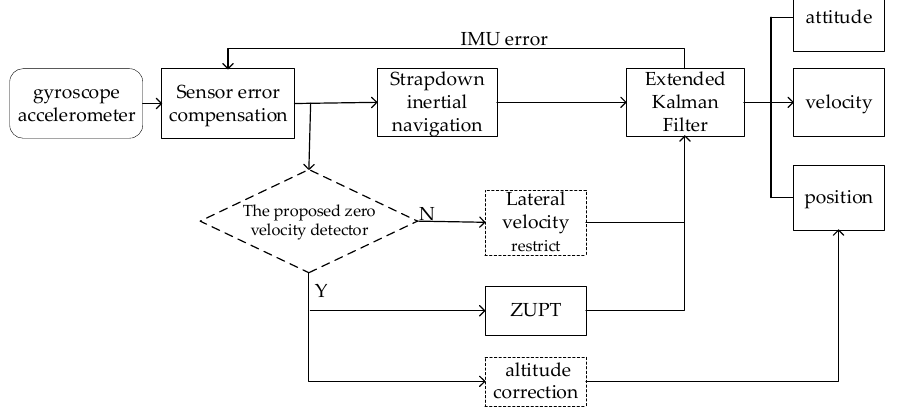
Figure 4. Flow chart of the proposed method.